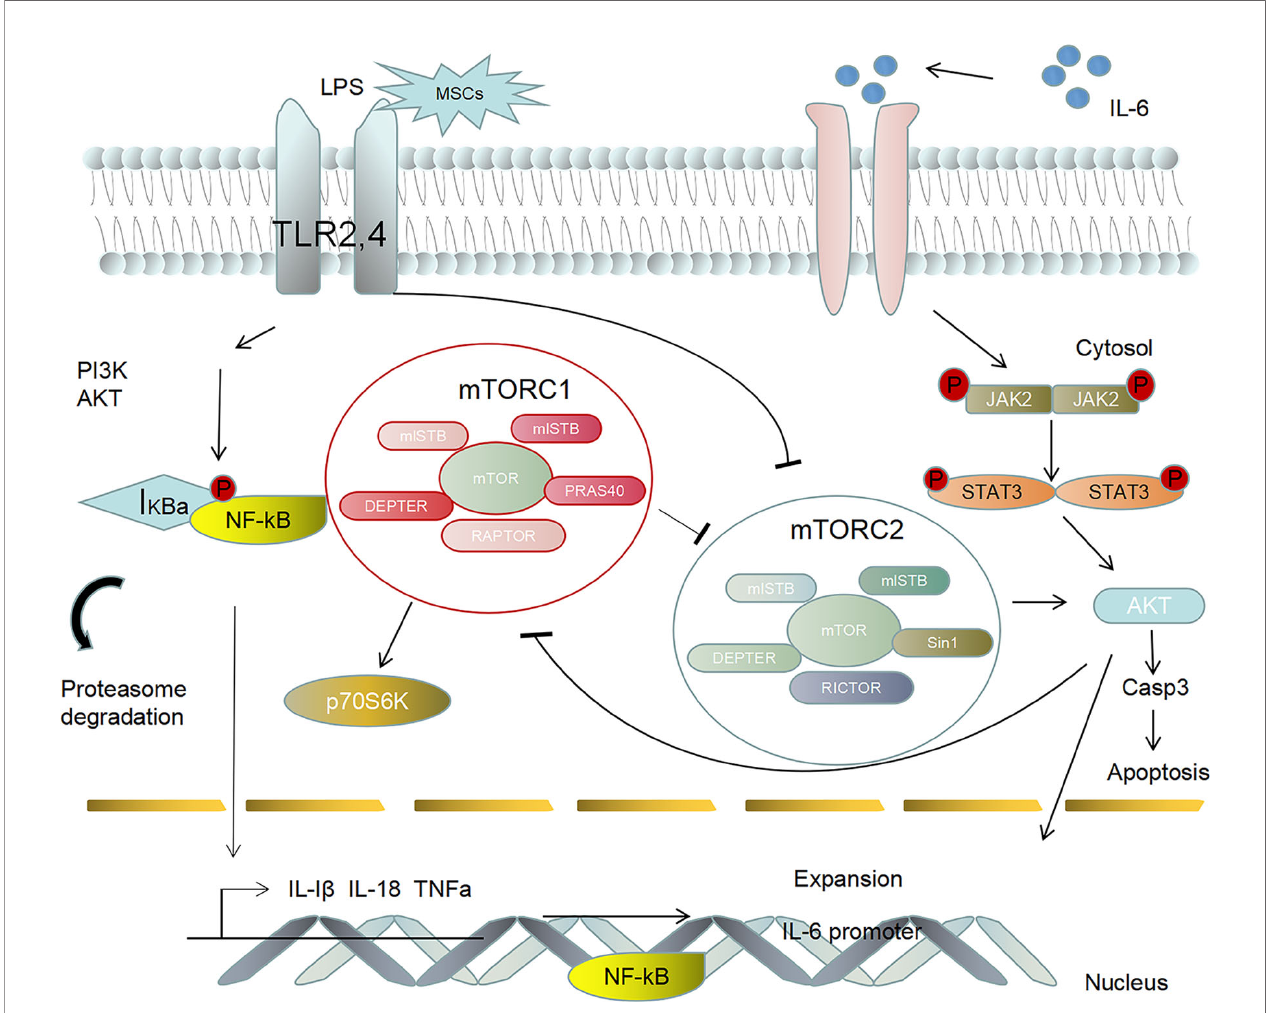
FIGURE 1 | MSCs activate the adaptive immune response by recognizing Toll-like receptors (TLR2, 4), thus activating the PI3K/AKT and NF- k B signaling pathways to regulate the in fl ammatory response. Furthermore, MSCs can regulate the abnormal secretion of the anti-in fl ammatory cytokine IL-6, thus promoting the activation of the downstream signaling factors JAK2 and STAT3. The phosphorylation of signaling pathway factors induces NF- k B activation to promote the expression of IL-I b , IL-18, TNF- a and IL-6 in the cytoplasm to the nucleus, which leads to an in fl ammatory